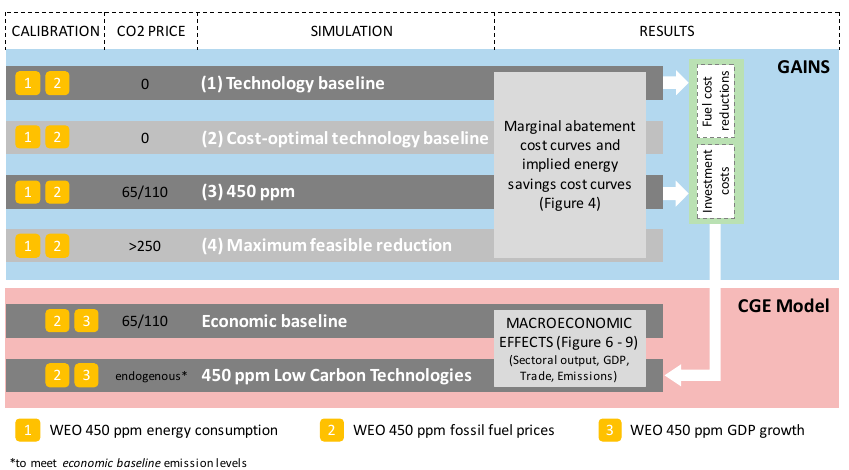
MACROECONOMIC EFFECTS (Figure 6 -9) (Sectoral output, GDP,